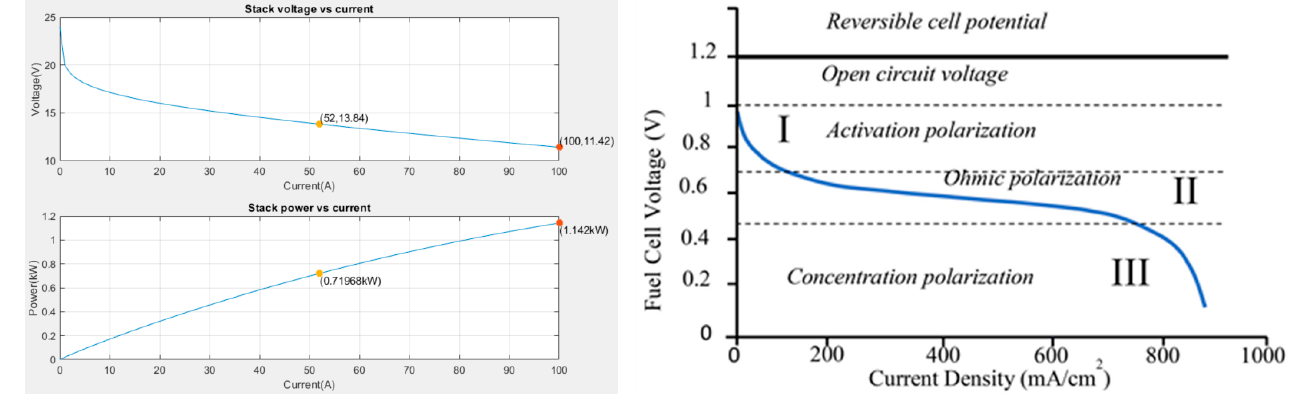
Figure 5. V ‐ I and P ‐ I Curve for a specific 720 W FC ( left ) and V ‐ I curve for a general FC ( right ) [30]. The ELY control is also based on the SoC of the LIB. The control scheme is shown in Figure 6.